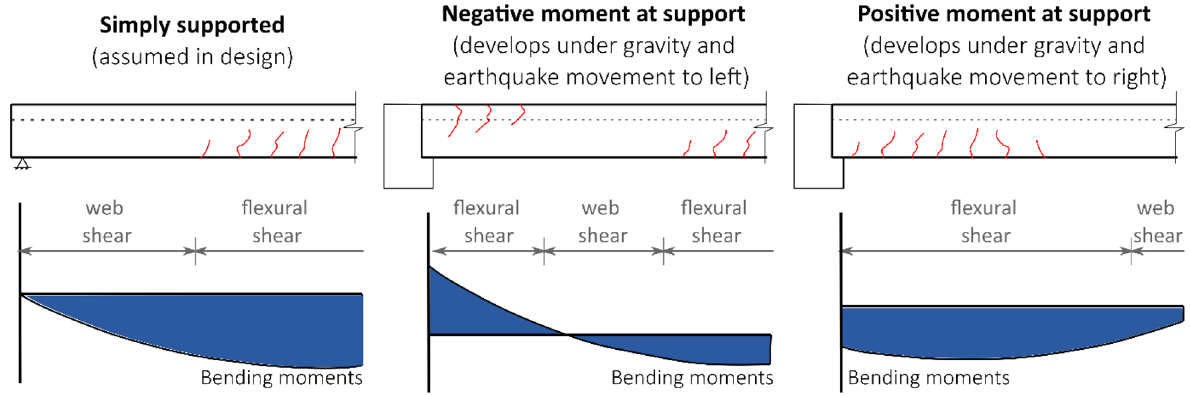
Fig. 2 Flexural and web-shear limits on shear strength of concrete [adapted from Fenwick et al. (2010)]